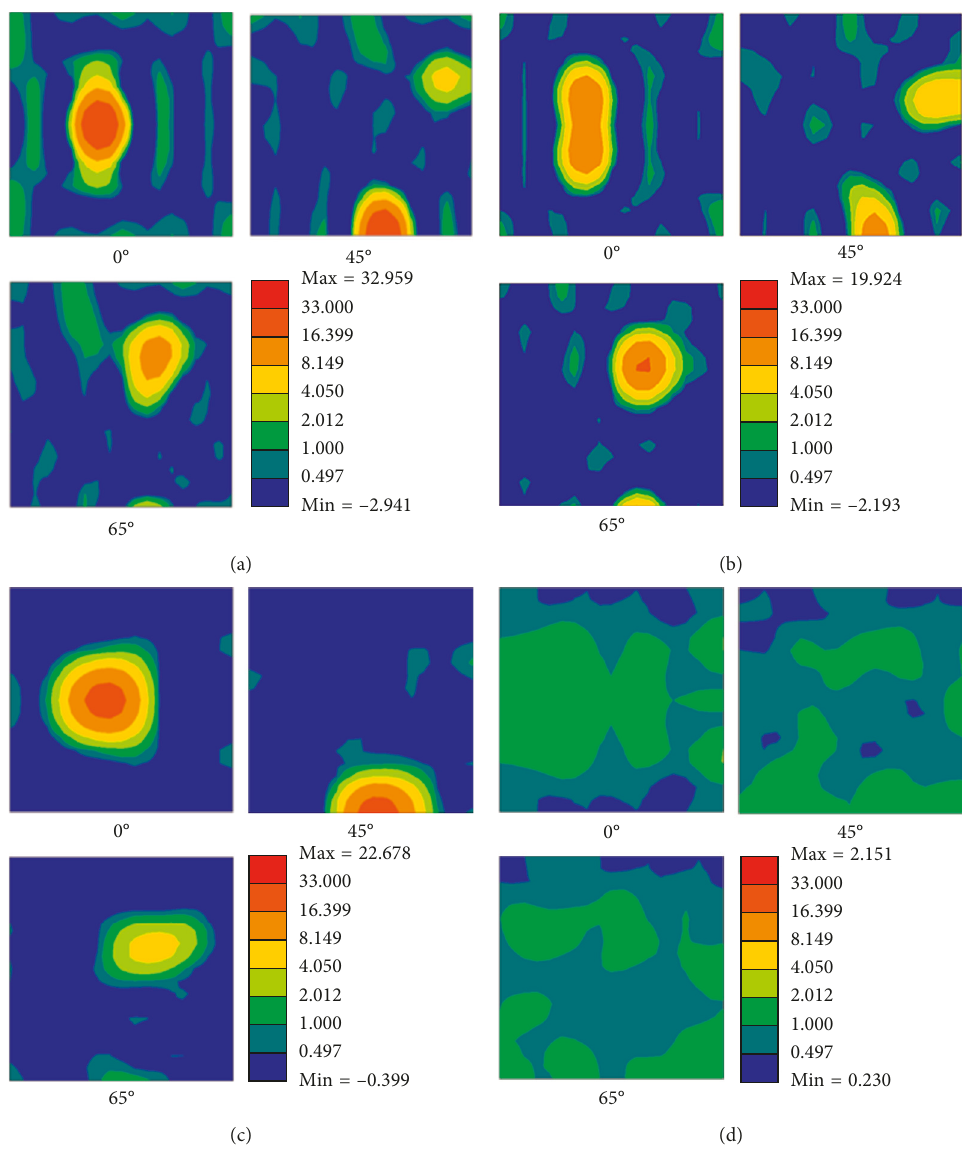
2 1 after interrupting the 10 s × · − −